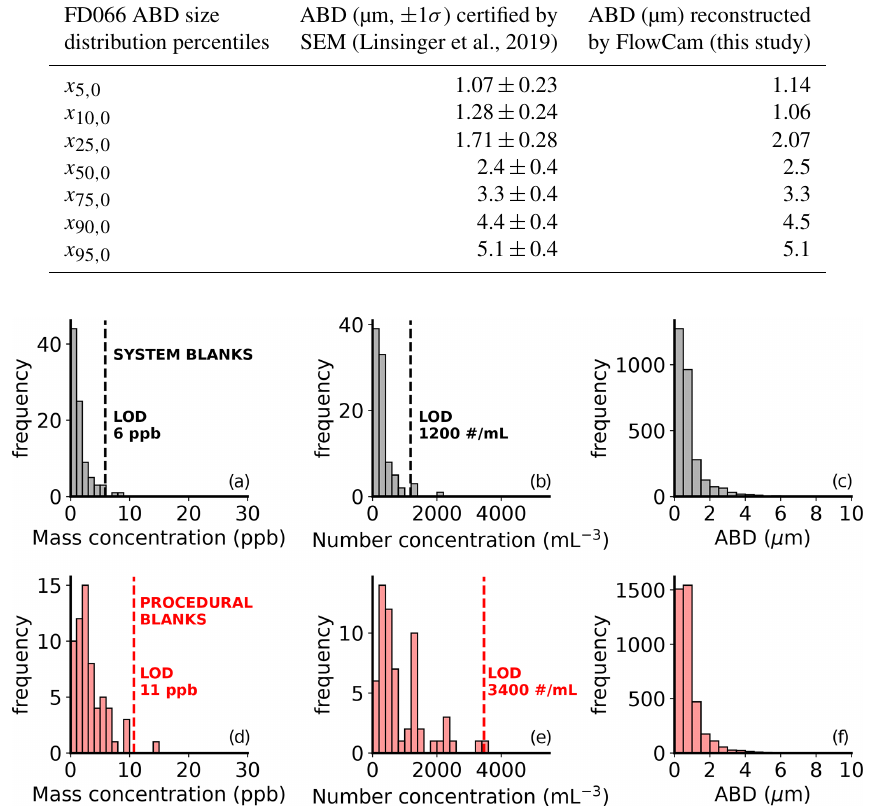
Figure 3. Analysis of n = 91 system blanks (black; a , b , and c ) and n = 63 procedural blanks (red; d , e , and f ). Panels (a) and (d) show the median mass concentrations of 1.0 ± 1.6ppb (parts per billion; 1 σ ) and 2.4 ± 2.8ppb (1 σ ) result in a 3 σ LOD of 6ppb for system blanks and 11ppb for procedural blanks, respectively. Panels (b) and (e) show the number concentration distributions and respective LOD. Panels (c) and (f) indicate the size distributions of blank particles in system ( c ; N = 2864) and procedural ( f ; N = 3945) blanks, rarely exceeding 3µm. All particles are classified as dust by the model. The mass concentrations are calculated assuming a density of 2.5gcm − 3 .